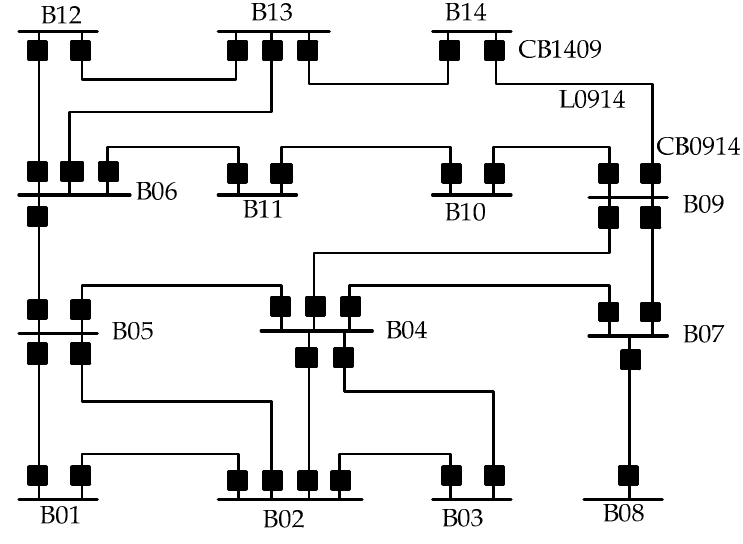
Figure 5. The tested IEEE 14-bus power system.